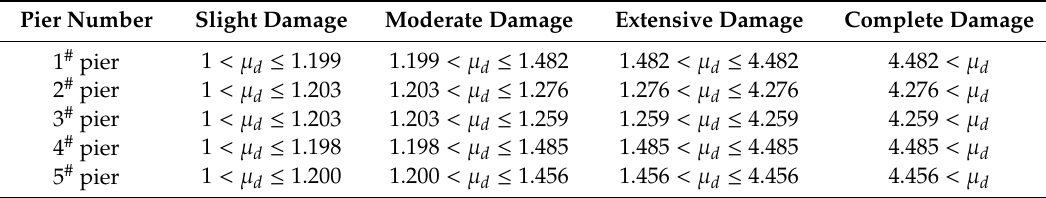
Table 2. Damage index of piers.